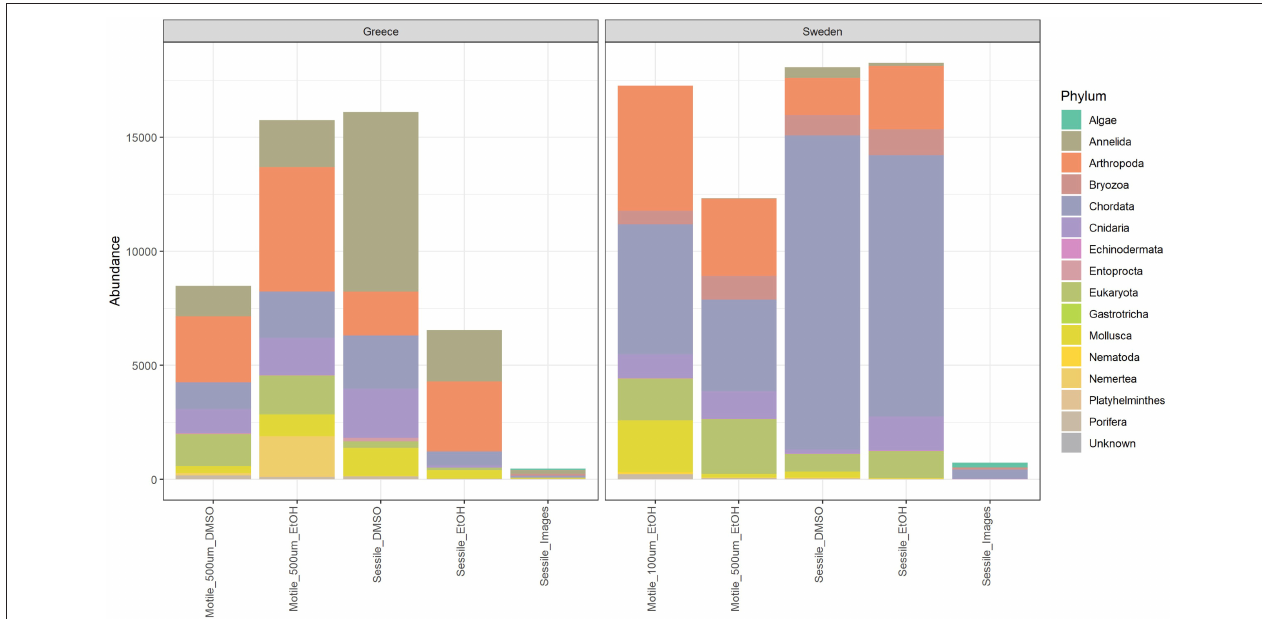
FIGURE 2 | Bar chart showing the relative abundances of the main taxa based on the COI gene and image analysis, at the phylum level, across the different fractions of two ARMS (Greece ARMS: Crete_1HERP_180928-190128, Sweden ARMS: Koster_VH2_180418-180906).